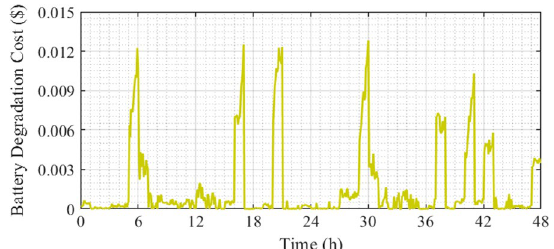
Fig. 8 Battery degradation cost during dispatch horizon